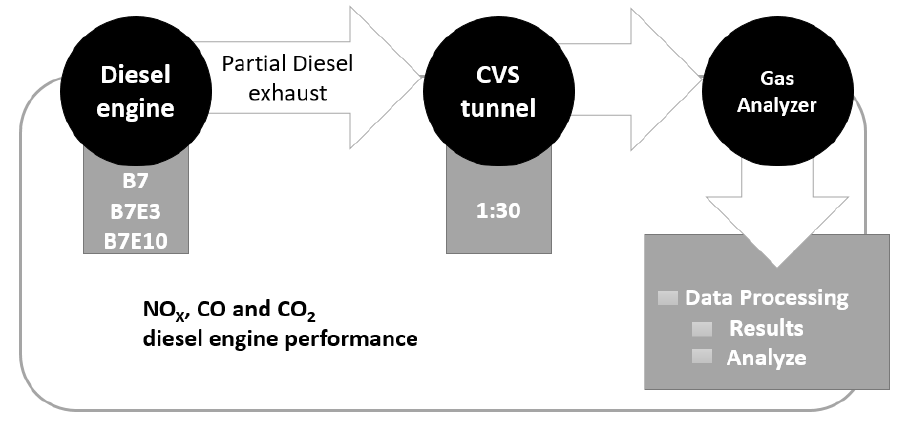
Figure 1. Schematic of experimental